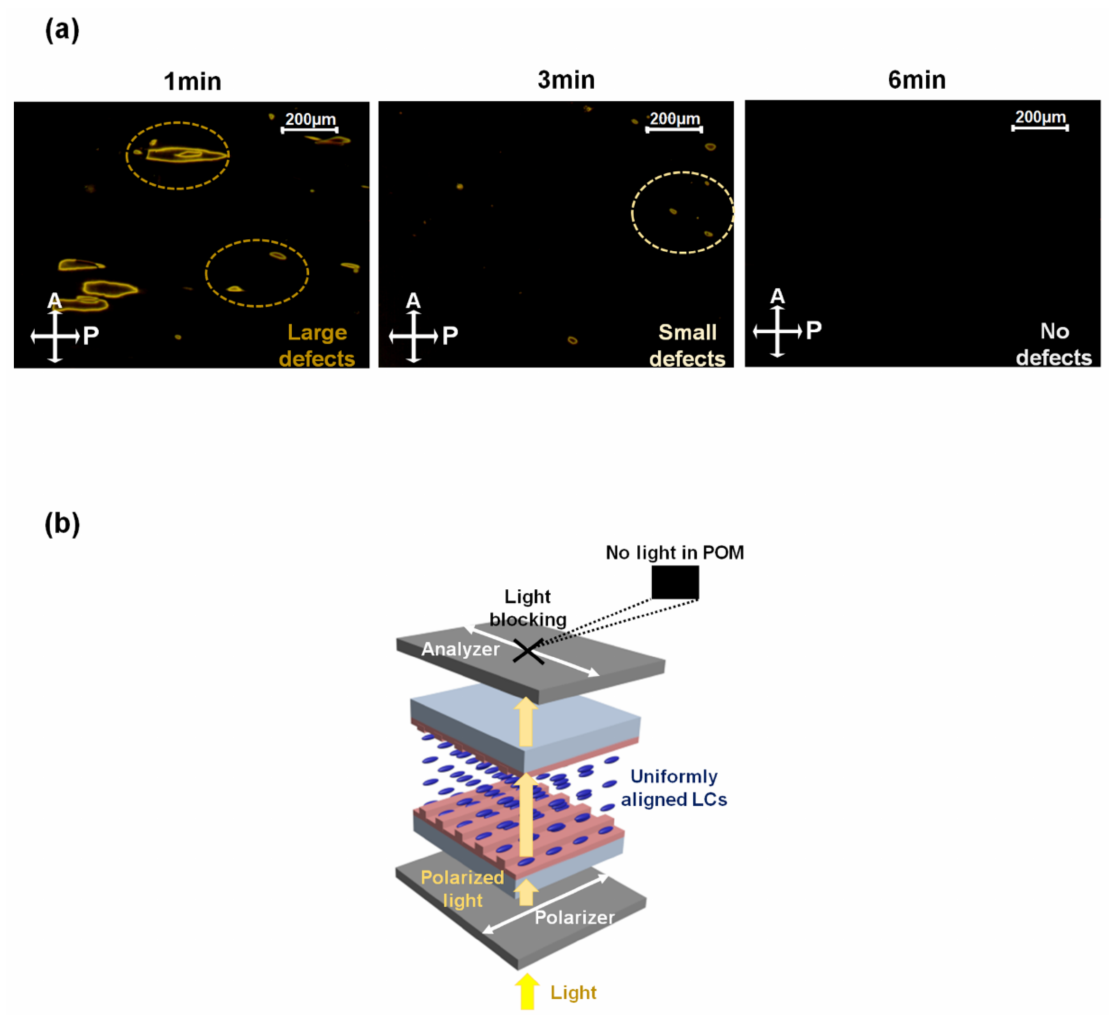
Figure 6. ( a ) POM images of the fabricated AP-LC cells assembled from 1 min, 3 min, and 6 min UV-exposed hybrid films (the directions of the analyzer (A) and polarizer (P) are presented by white arrows). ( b ) Schematic of the light path during passage through the AP-LC cell comprising uniformly aligned LCs on unidirectional hybrid films; no light leakage is